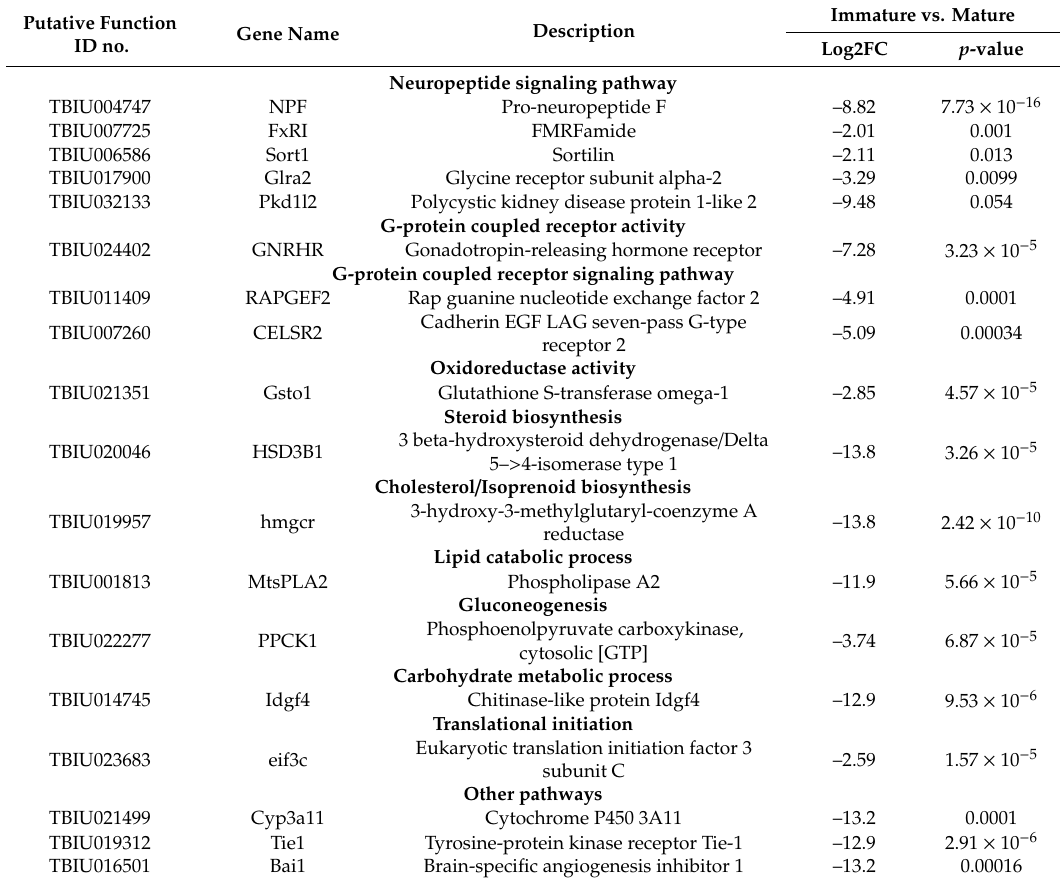
Table 2. List of significant differentially expressed genes between immature and mature Haliotis discus